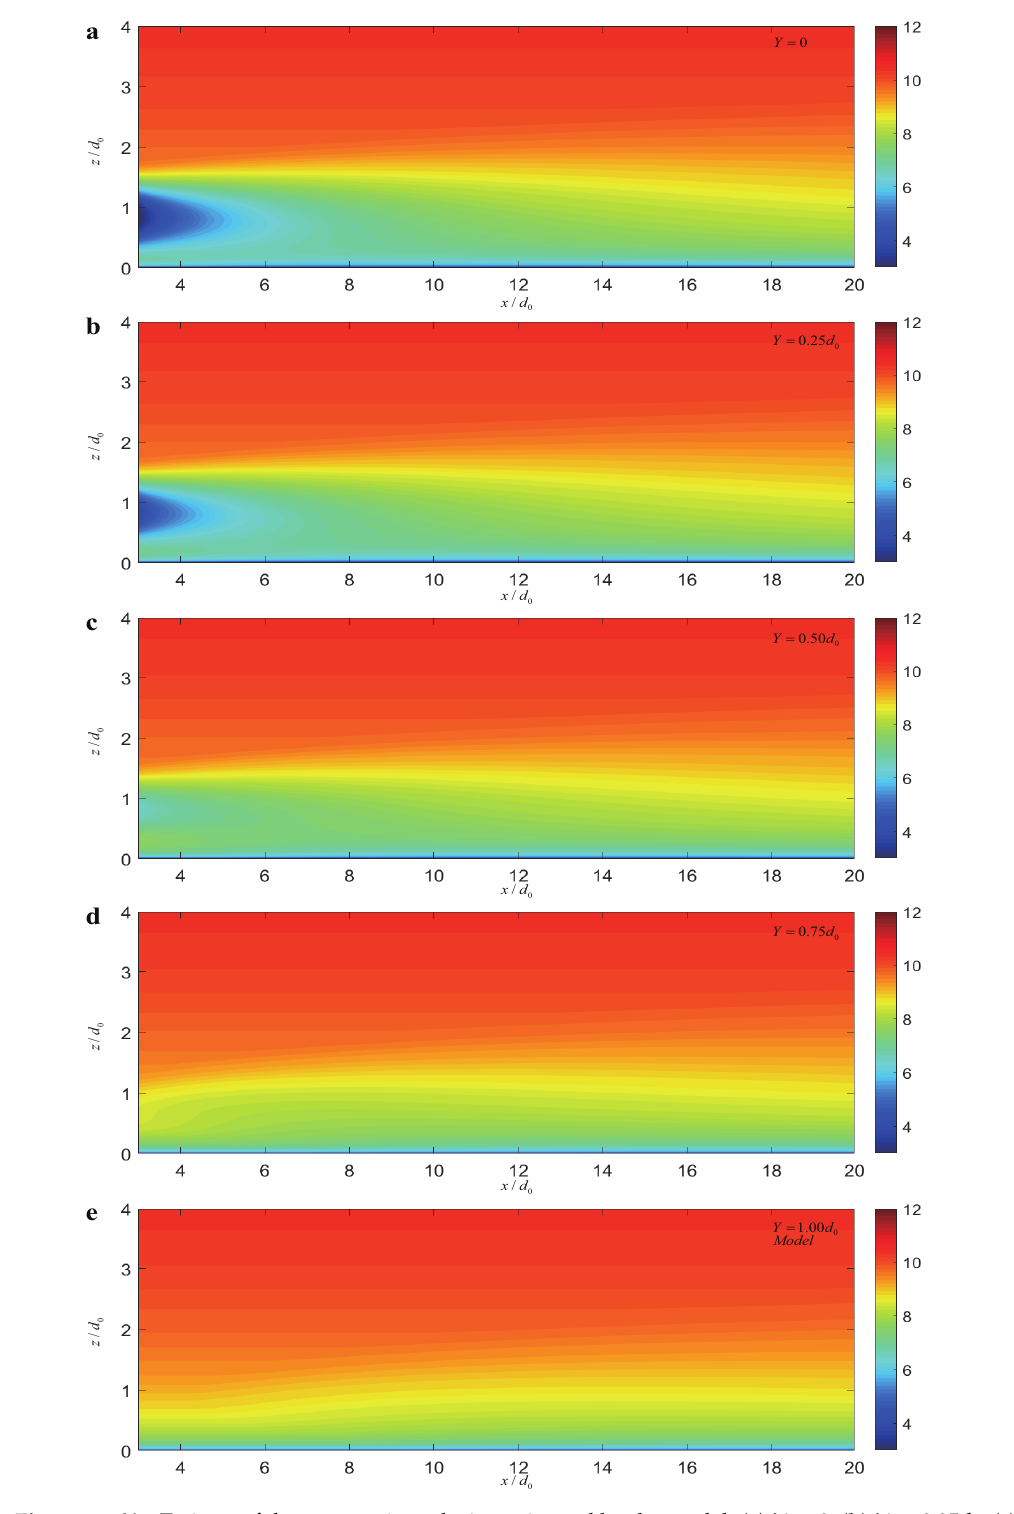
Figure 14. X – Z views of the streamwise velocity estimated by the model: ( a ) Y = 0; ( b ) Y = 0.25 d 0 ; ( c ) Y = 0.5 d 0 ; ( d ) Y = 0.75 d 0 ; ( e ) Y = 1.00 d 0